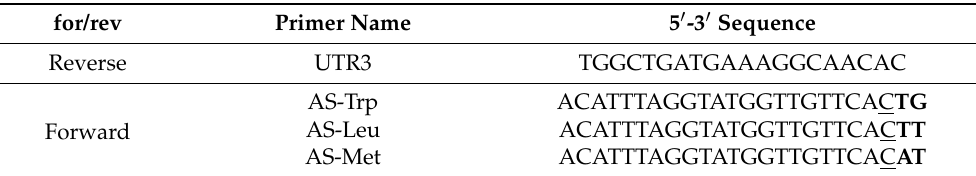
Table 1. Sequence of primers used for the allele-specific assay (PASA). An additional mismatch (A → C, underlined) was introduced to increase primer specificity, but at the third-to-last base of the primers instead of the penultimate base as elsewhere suggested [36]. for/rev